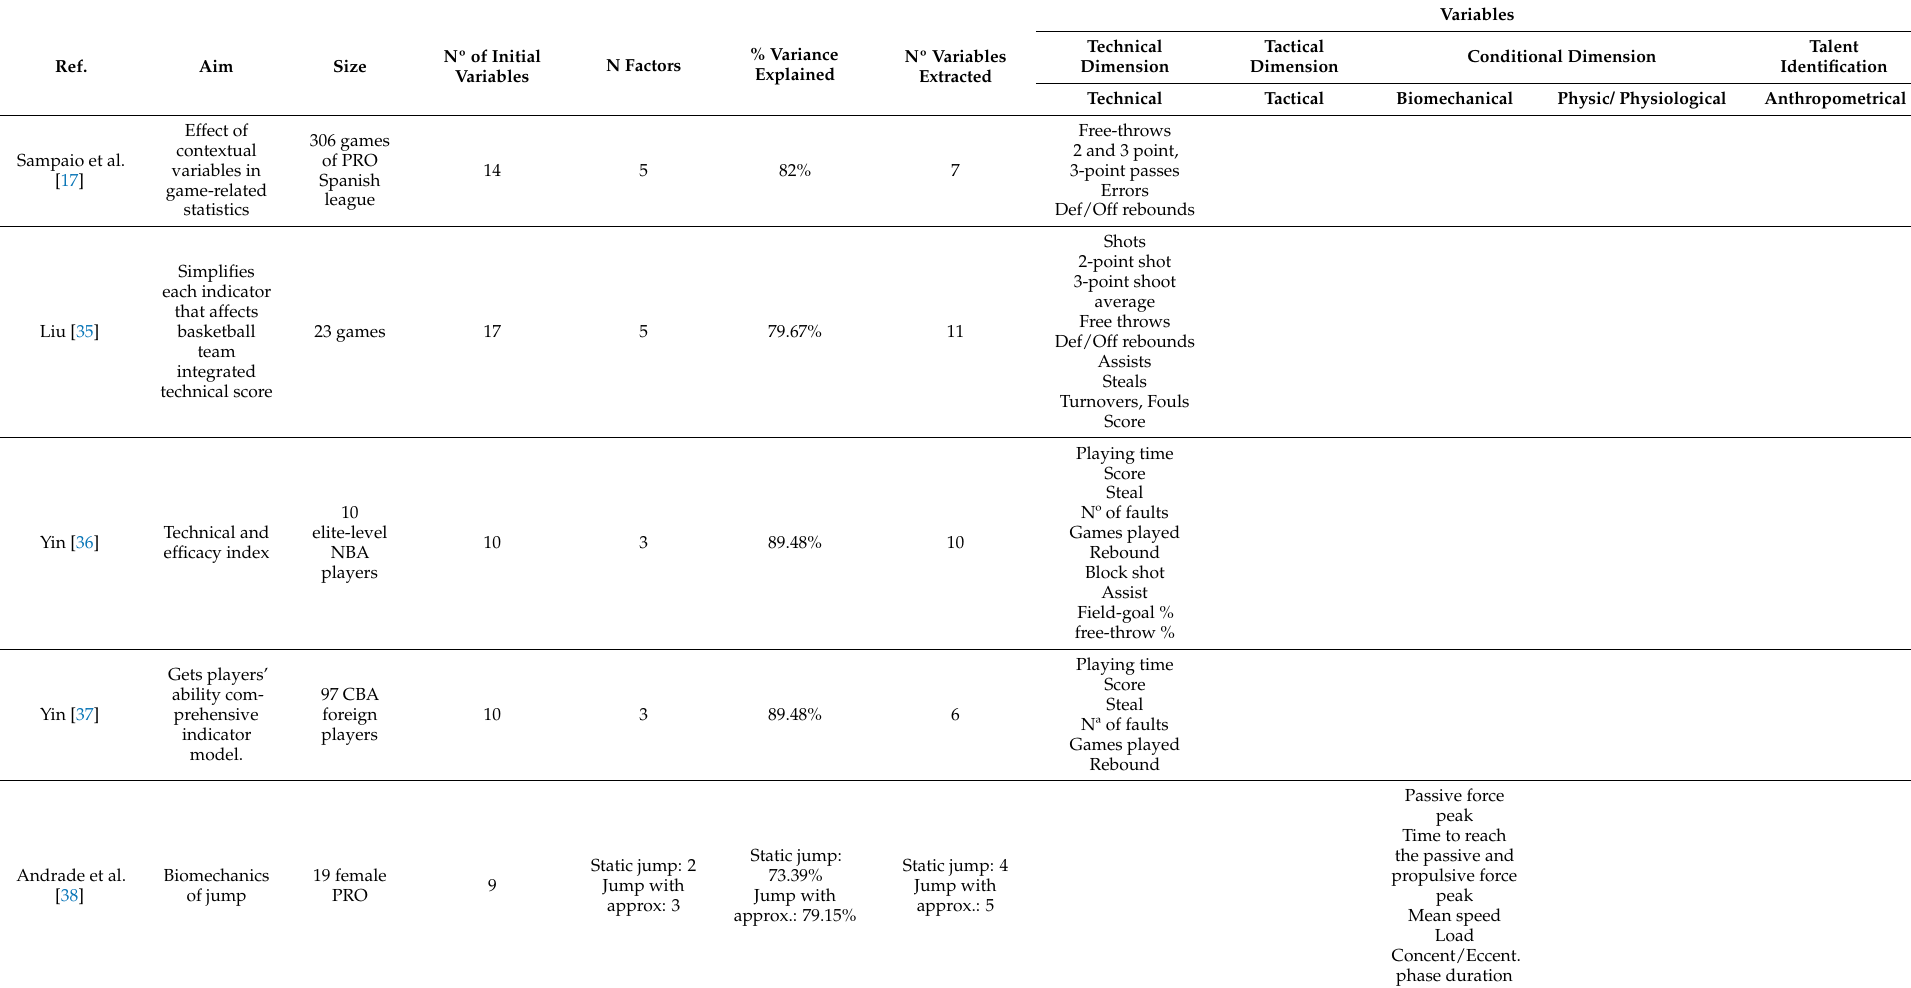
Table 2. Variables extracted through PCA in